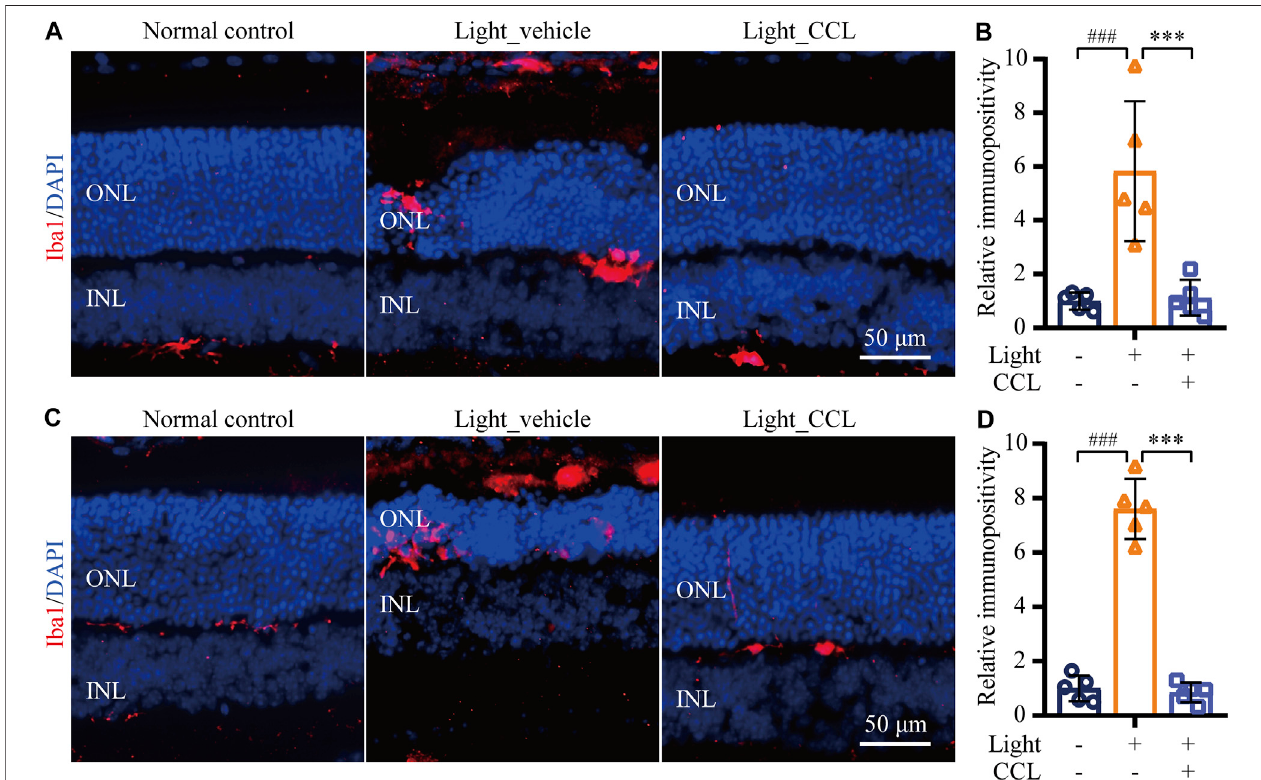
FIGURE 9 | CCL mitigates microglial activation in the light-exposed retinas. IHC was performed to examine the expression of Iba-1 in the retina (in red). Counterstaining of DAPI (in blue) was performed. The immunopositivity of Iba-1 in the outer retina including ONL and the subretinal space was quanti fi ed by ImageJ. (A) RepresentativemicrographsdemonstratingIba-1positivityfromtheeyesenucleated24 hafterlightexposure. (B) TherelativefoldchangeintheimmunopositivityofIba- 1 from (A) wasplotted against that from Normal control. (C) Representative micrographs demonstrating Iba-1 positivity from the eyes enucleated 3 days after light exposure. (D) TherelativefoldchangeintheimmunopositivityofIba-1from (C) wasplottedagainstthatfromNormalcontrol.INL,inner nuclearlayer;ONL,outernuclear layer. Scale bar, 50 μ m. Data were expressed as mean ± SD (n = 5 per group). ### Compared to Normal control, p < 0.001; *** compared to Light_vehicle, p <